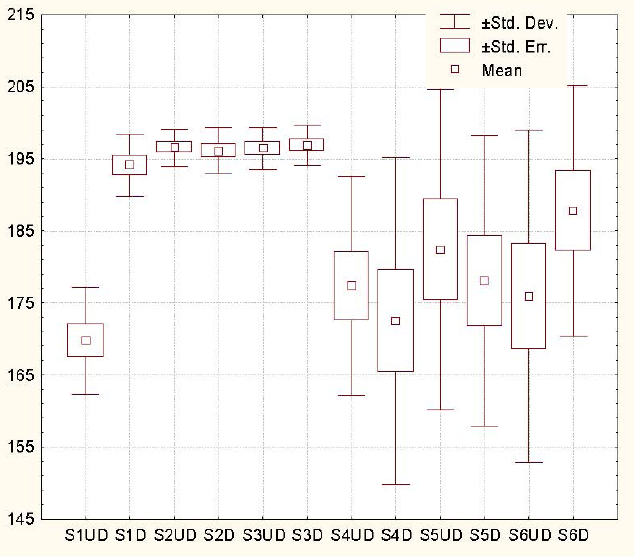
Figure 5: A box and whisker plot (of C ured in milliseconds) for each subject is